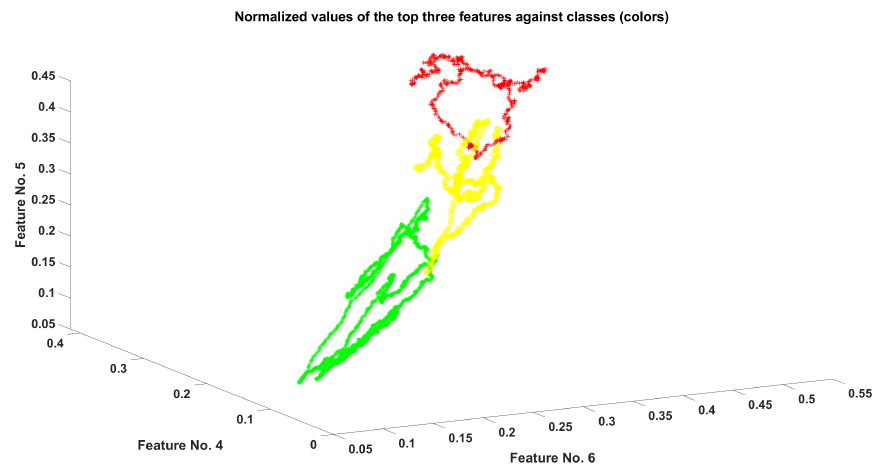
Figure 8. Normalized values of the top three features against classes (colours: green, yellow, and red). Based on the classification algorithms, a cross-validation method was used based on the entire dataset, containing 8540 images of holes. For each degree of drill wear (Good, Worn, Requiring replacement), the Pareto rule 80/20 was applied—80% of the data were used for training, and the results were tested on the remaining 20% of examples. Each classifier model was evaluated for different values of two chosen parameters— i and j . The main loop operated for the step length parameter in the regression correction cycle for i -previous images in the range 1 to 200. The second loop operated for the number of used features, from the selected set, ranging from 1 to 9 (parameter j ). The features were added in the order of increasing effectiveness, starting with best performing